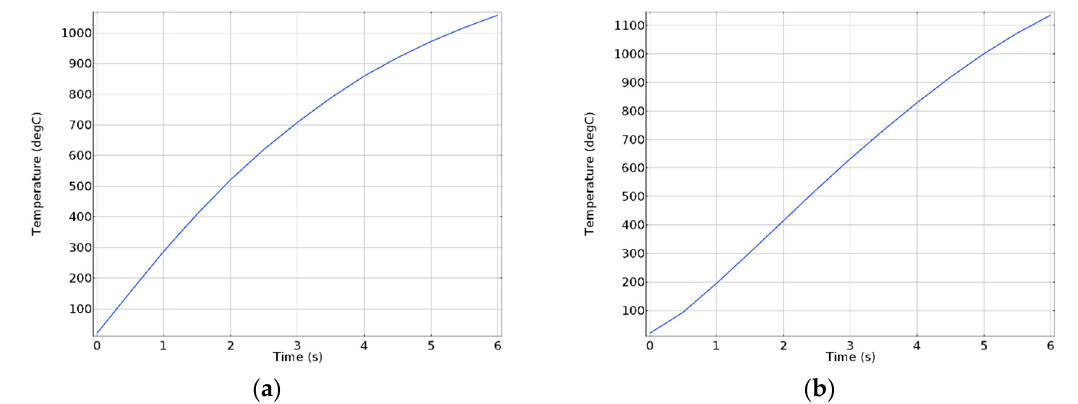
Figure 7. Heating—brazing assembly, ( a ) copper, ( b ) stainless steel.